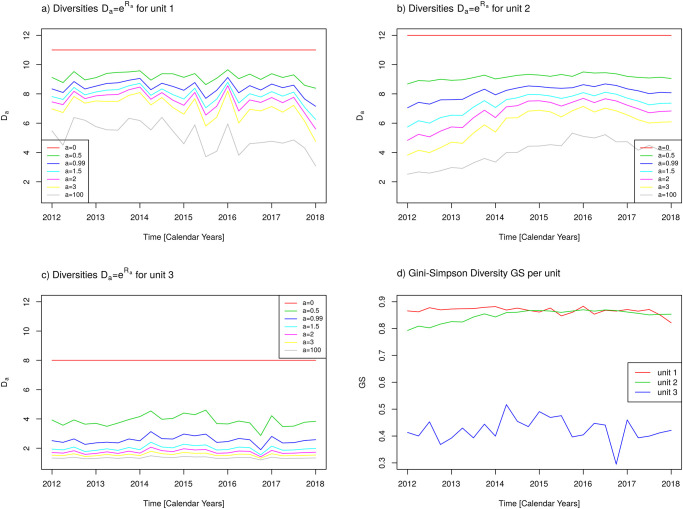
Measures of diversity with respect to antibiotic classes stratified by functional units.a) Diversities Da for unit 1 with a = 0, 0.5, 0.99, 1.5, 2, 3, 100, b) Diversities Da for unit 2 with a = 0, 0.5, 0.99, 1.5, 2, 3, 100, c) Diversities Da for unit 3 with a = 0, 0.5, 0.99, 1.5, 2, 3, 100, d) Gini-Simpson Index GS. See text for definitions.